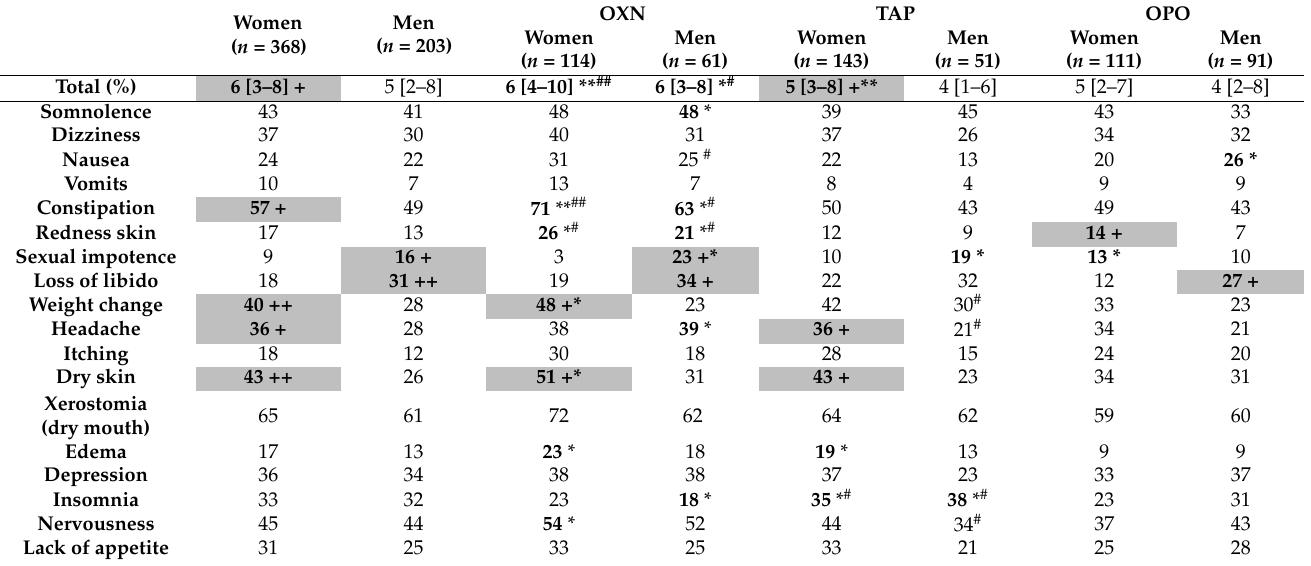
Table 3. Percentage of patients with adverse events of patients (AEs) self-reported in in women and men of other prescribed opioids (OPO), tapentadol (TAP) and oxycodone/naloxone (OXN) cases